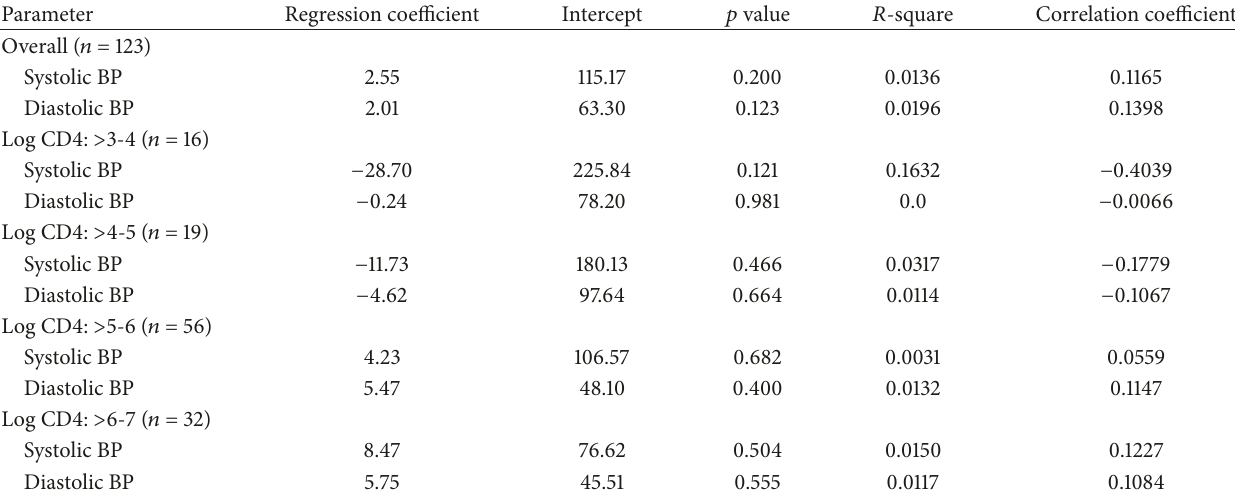
Table 3: Linear regression model for systolic and diastolic blood pressures and log CD4 cell